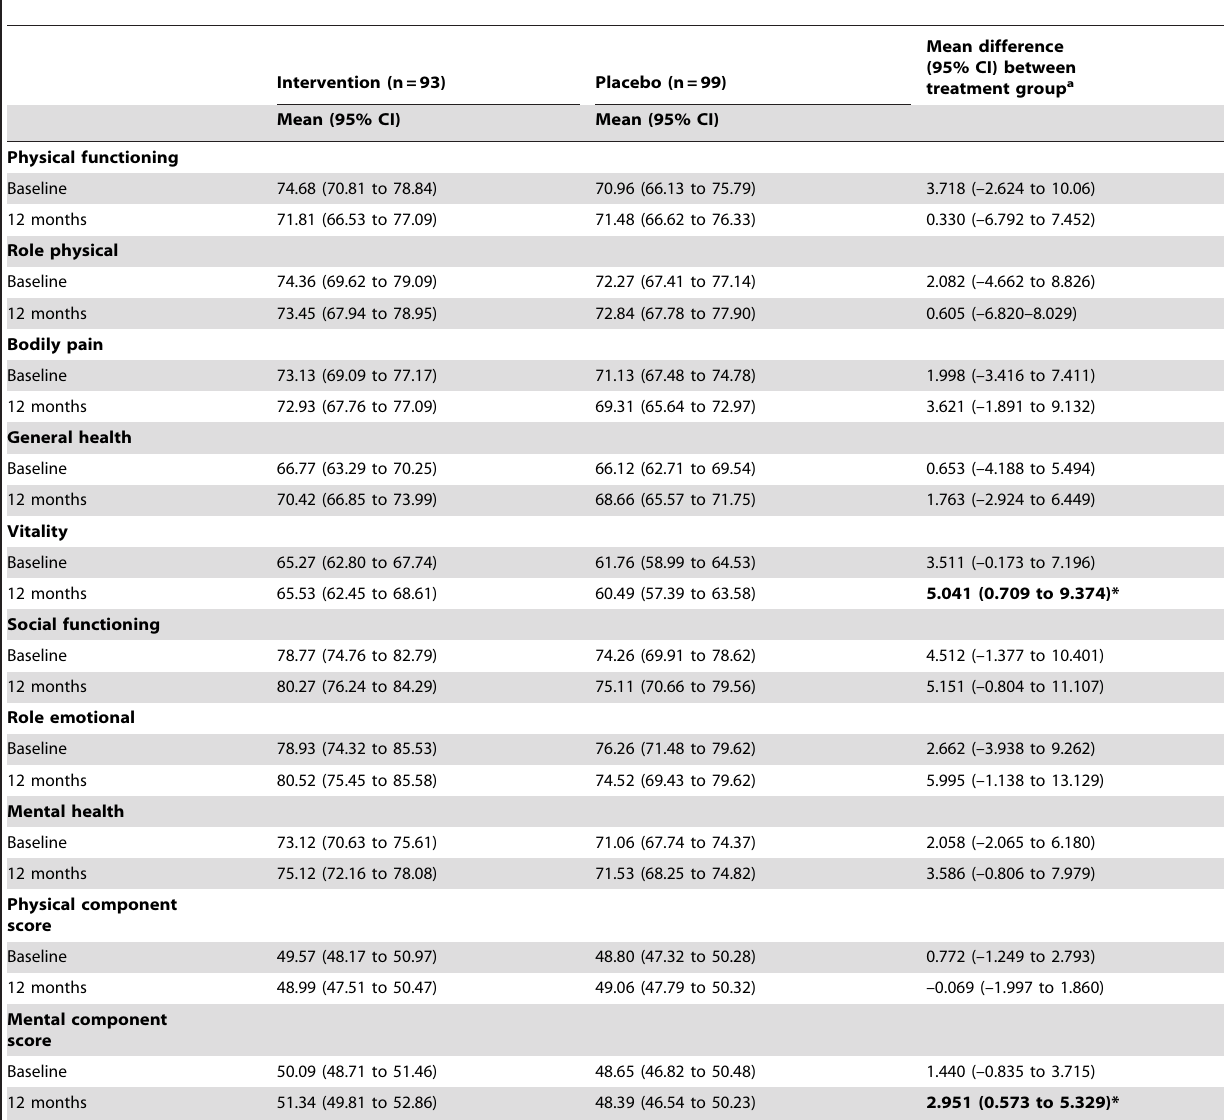
Table 3. Summary of the health-related quality of life parameters overtime (baseline and 12 months) – Intention-to-treat analysis.